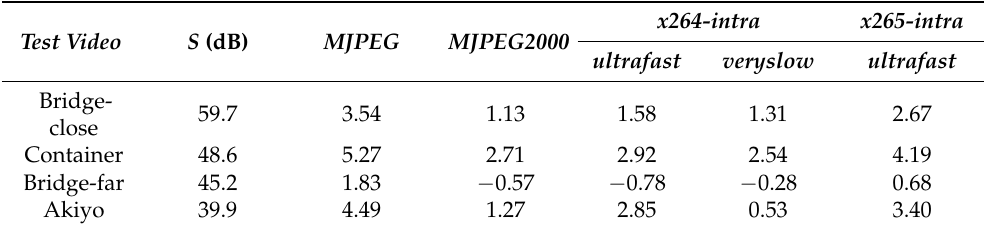
Figure 10. Rate distortion comparison using PSNR metric for Full HD videos. Table 6. BD-PSNR provided by CS-JPEG compared with different intra-frame